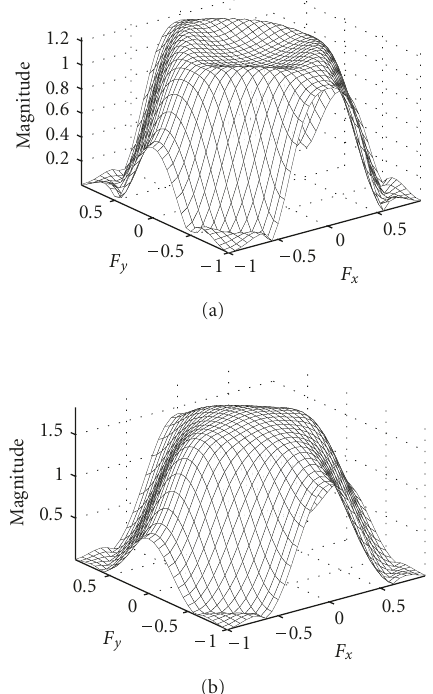
Figure 9: Frequency responses of the (a) lowpass analysis and (b) lowpass synthesis filters of OPT4.